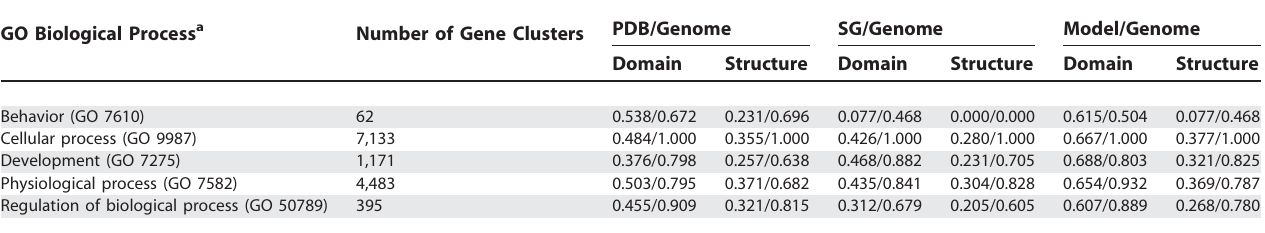
Table 3. Coverage/Kendall’s Tau Correlations for Major Categories of GO Biological Process for Both Single Domains and Whole